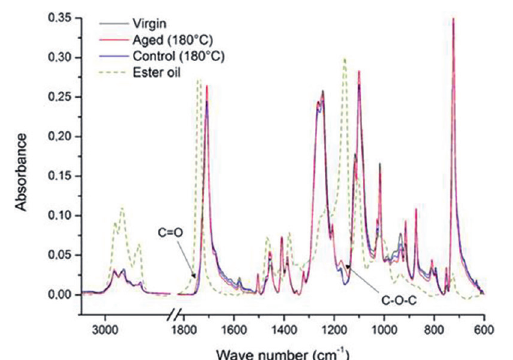
Figure 7: Comparison of PBT and ester oil FTIR spectra.